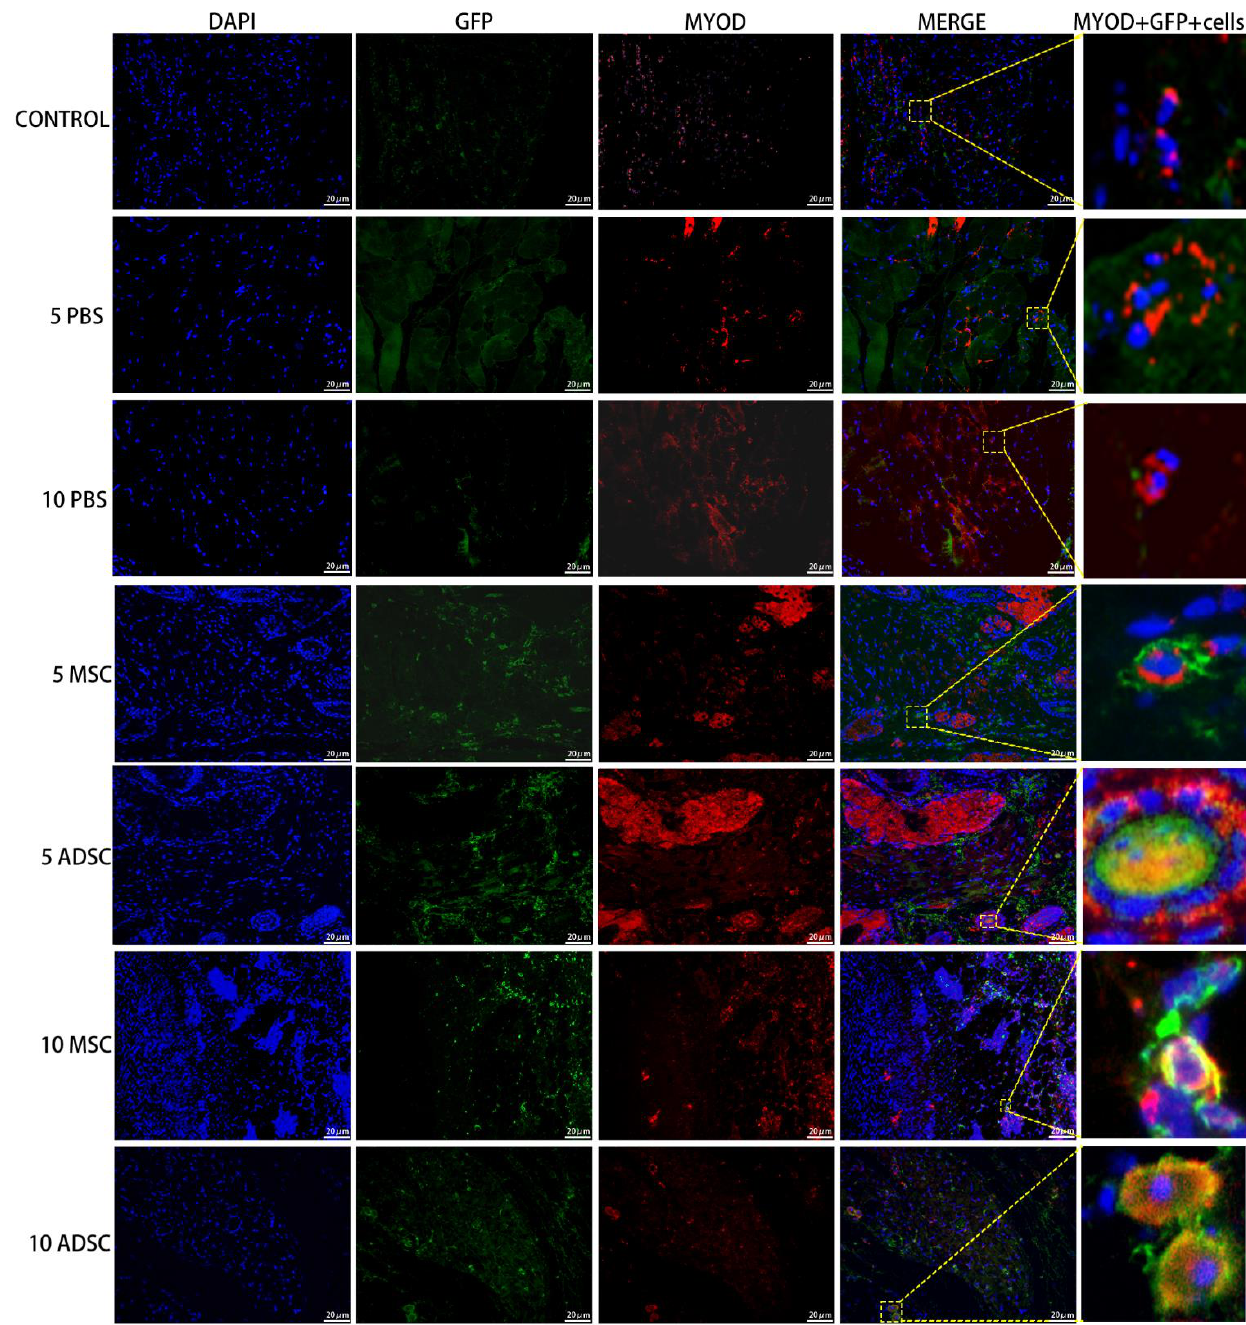
Figure 8. ADSC and MSC co-expressed GFP and PCNA after 5 and 10 days of injection. The 1st to 7th row represents staining of GFP and PCNA in the control group, PBS group on the 5th and 10th day, MSC and ADSC group on the 5th day, and MSC and ADSC on the 10th day, after the treatment.